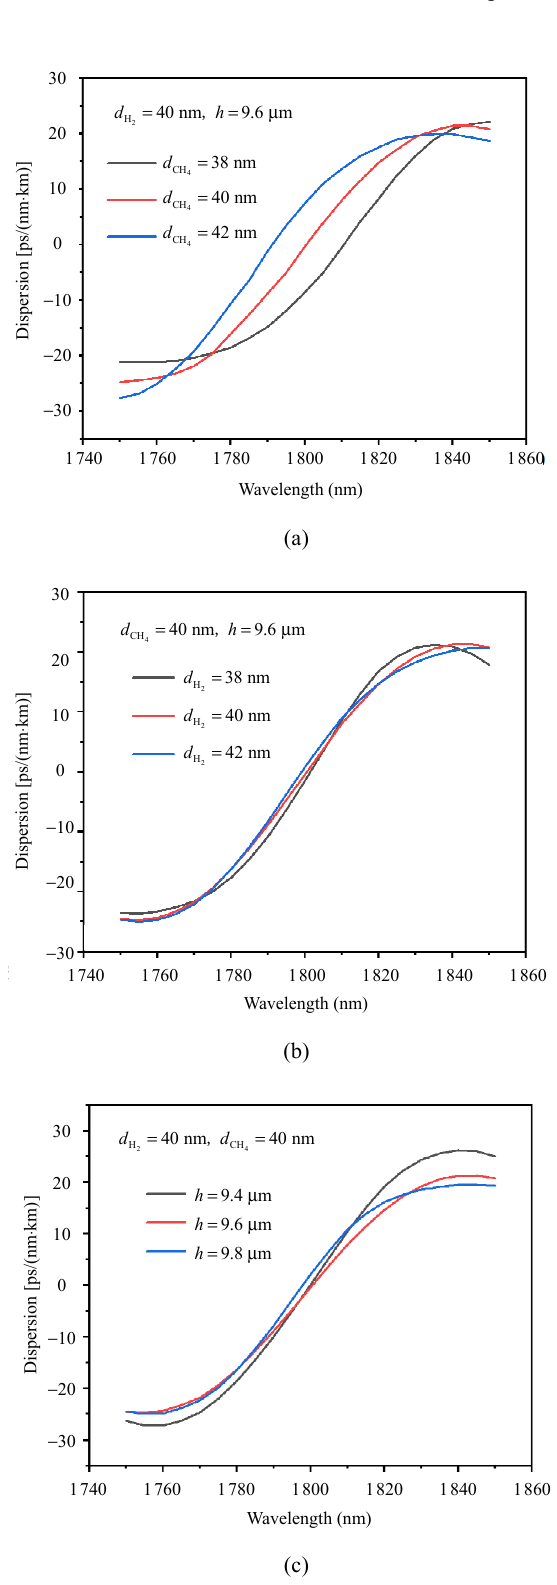
Fig. 2 Dispersion curves of the gold film thickness: (a) in air hole and (b) on the polished surface; (c) polishing